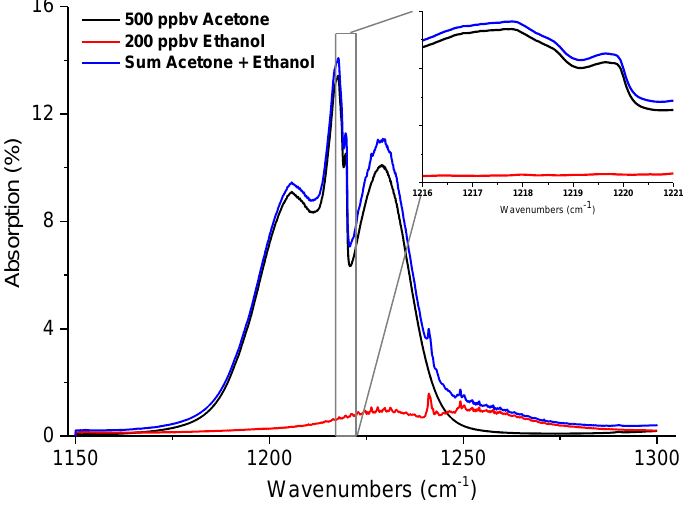
Figure 3. Simulation of absorption of 500 ppbv acetone and 200 ppbv ethanol at a pressure of 1 atm and a path length of 1 km from the PNNL (Pacific Northwest National Laboratory) database. The inset shows a zoom of the 1216 cm −1 region, showing the contribution of ethanol in this region, which results in an elevated absorption signal without significant lineshape variation for both contributions (upper curve, blue).